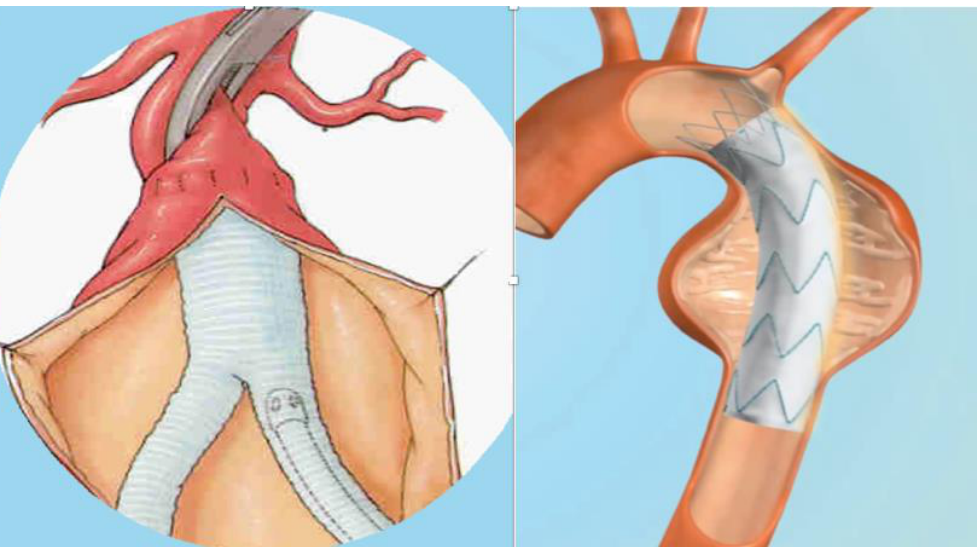
Figure 1. Vascular graft and vascular endograft. On the ( left ): vascular graft; on the ( right ): vascular endograft.